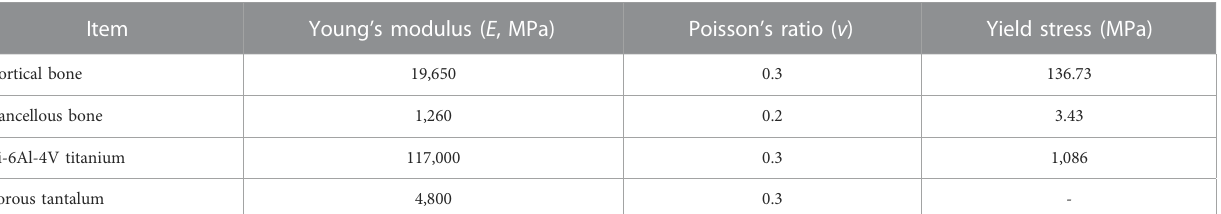
TABLE 1 Material properties de fi ned in the FE